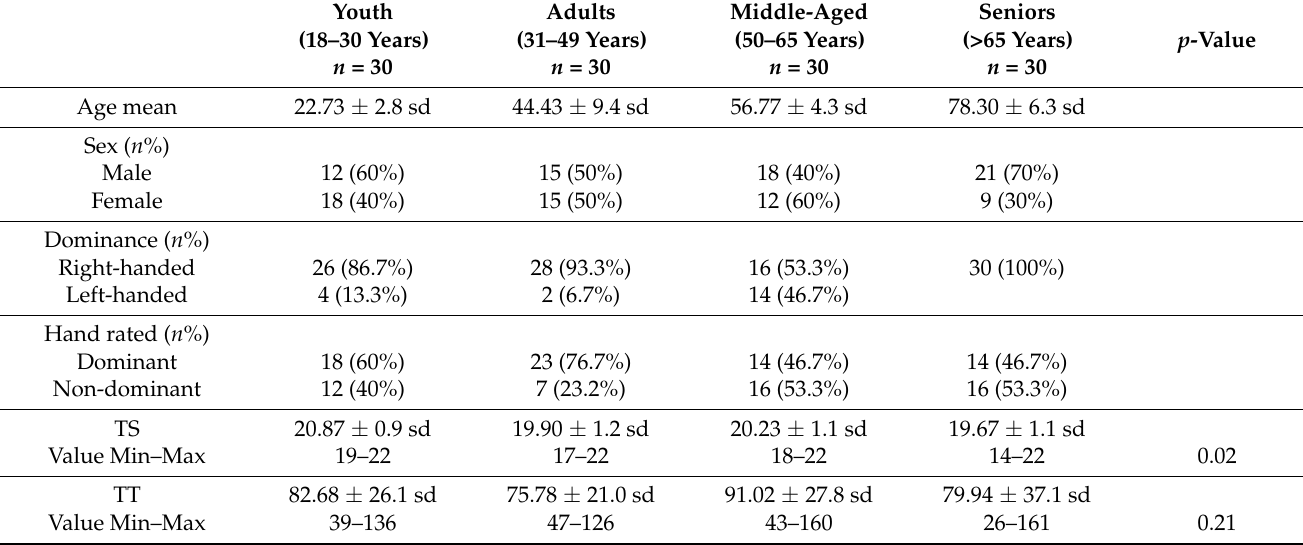
Table 1. Sociodemographic characteristics and stereognosis subtest scores for validation in the Spanish population ( n = 120).